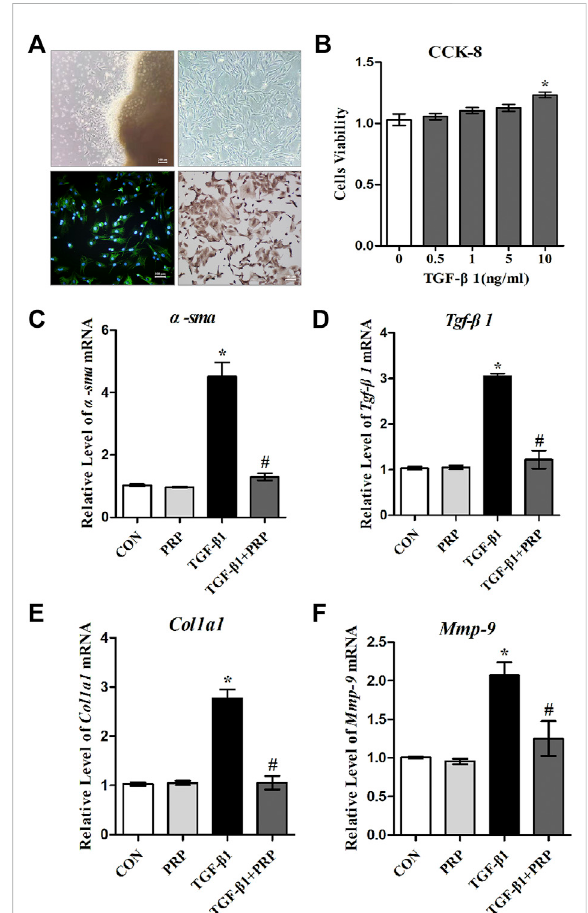
TTCA-3 ʹ ; Col- Ⅰ :forwardprimer5 ʹ -TGTATCACCAGACGCAGA